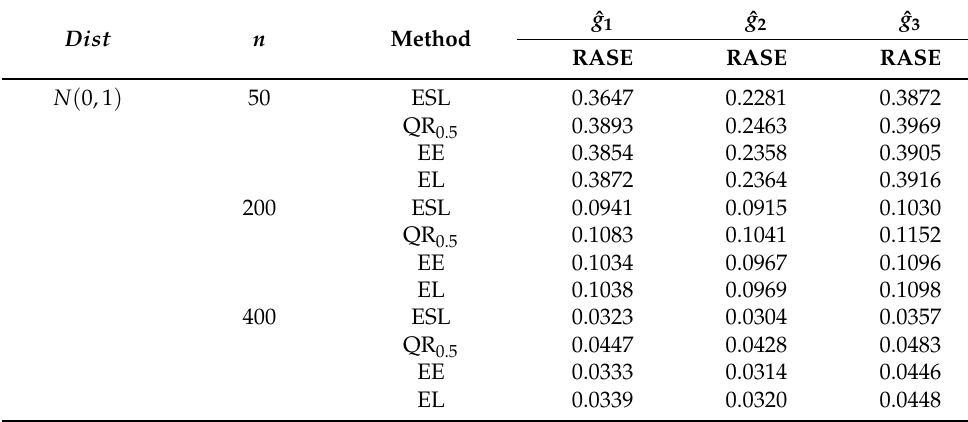
Table 2. Simulation results of RASE for the estimators of g i ( · )( i = 1,2,3 )